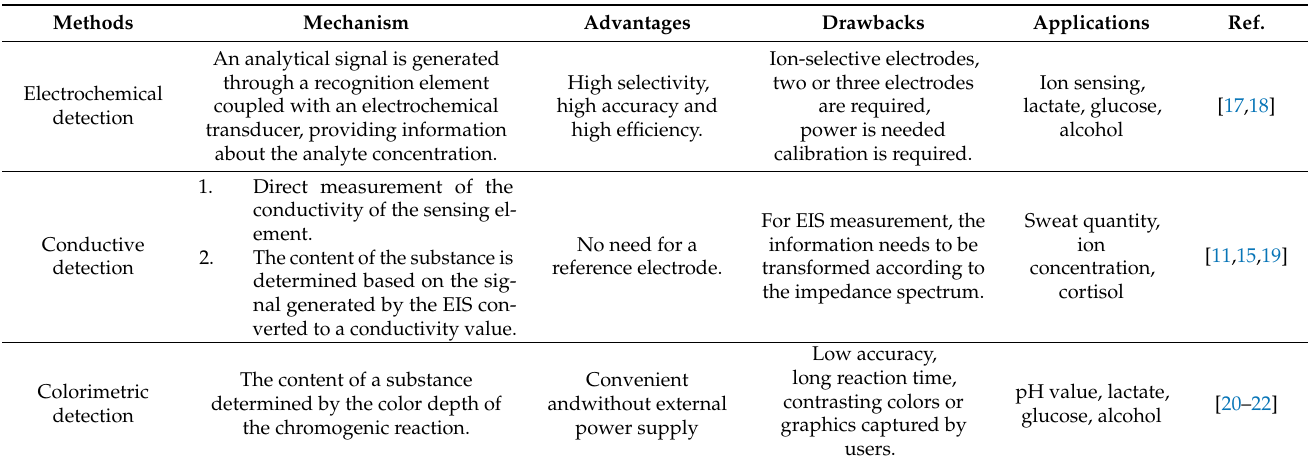
Figure 1. Illustration of textile-based sweat sensor. Table 1. Comparison of different mechanisms of sweat sensors.